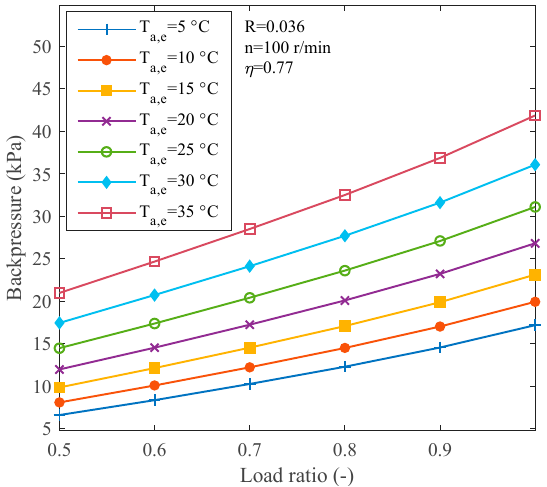
Figure 6. Backpressure at different ambient temperatures and load ratios.